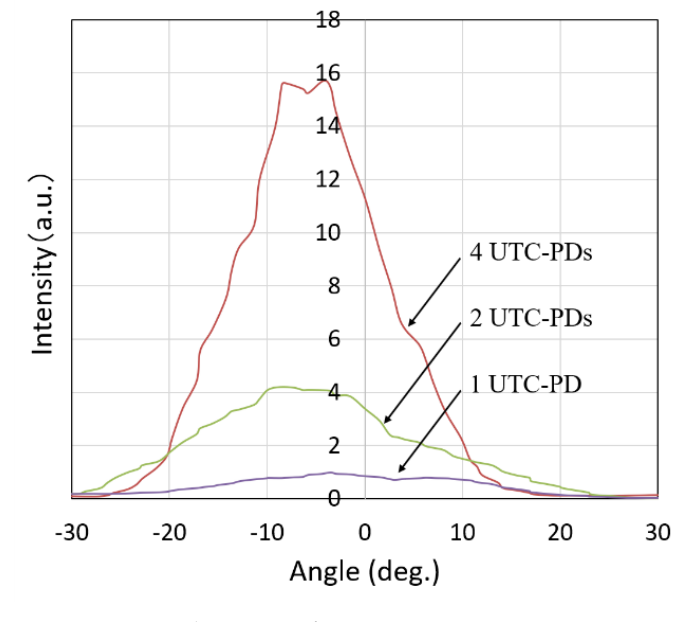
Figure 6. Measured intensity of 300 − GHz wave.